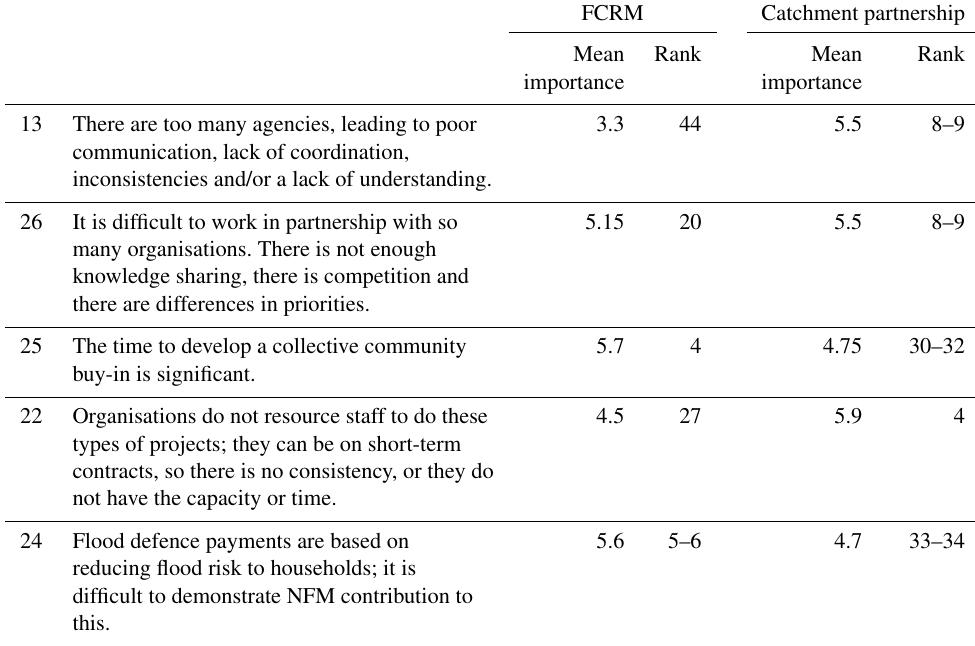
FCRM Catchment partnership Mean